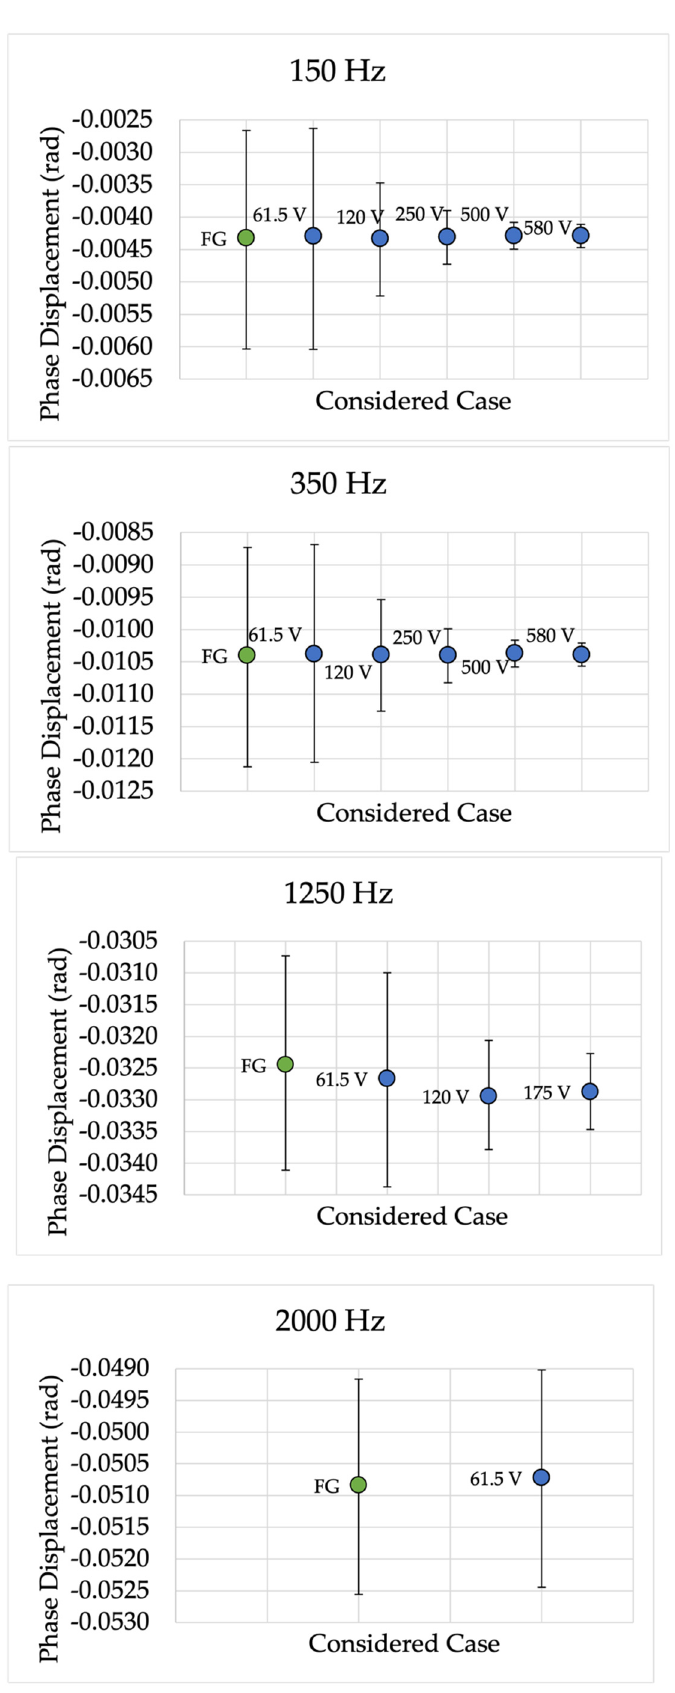
Figure 6. Phase displacement 95% confidence intervals for different frequencies and for device A.